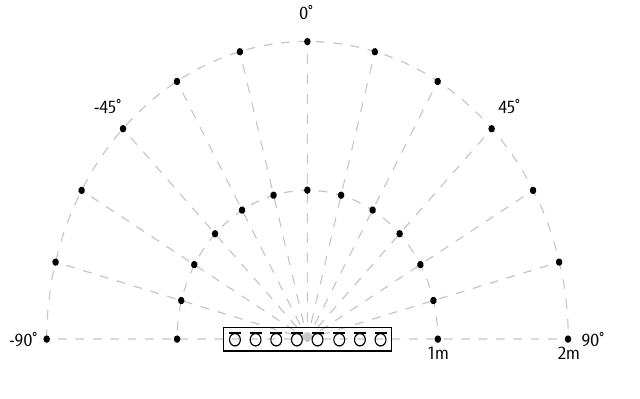
Figure 3. Multichannel Impulse Response Database measurement space configuration diagram